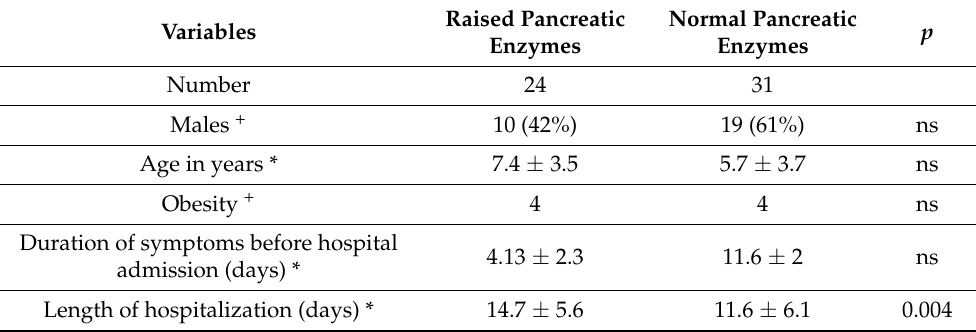
Table 3. Baseline characteristics of patients with MIS-C with and without pancreatic